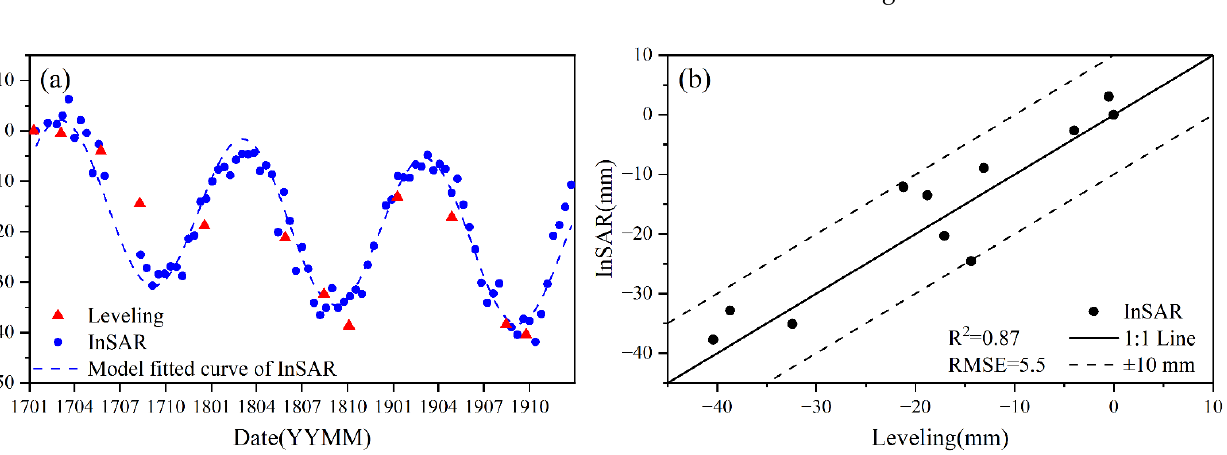
leveling measurements, respectively. Figure 4 indicates that the R 2 and RMSE of SBAS-InSAR observation and leveling measurements are 0.87 and 5.5 mm, respectively, and the maximum difference is 10.2 mm. It indicates that the SBAS-InSAR observation and leveling measurements are consistent.